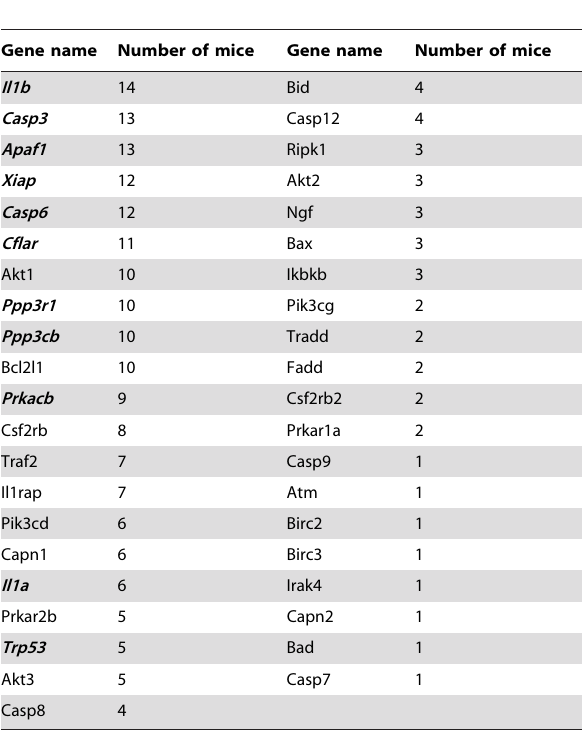
Table 1. ‘‘Average analysis’’ and ‘‘heterogeneity analysis’’ of cell death regulation reveal different genes.